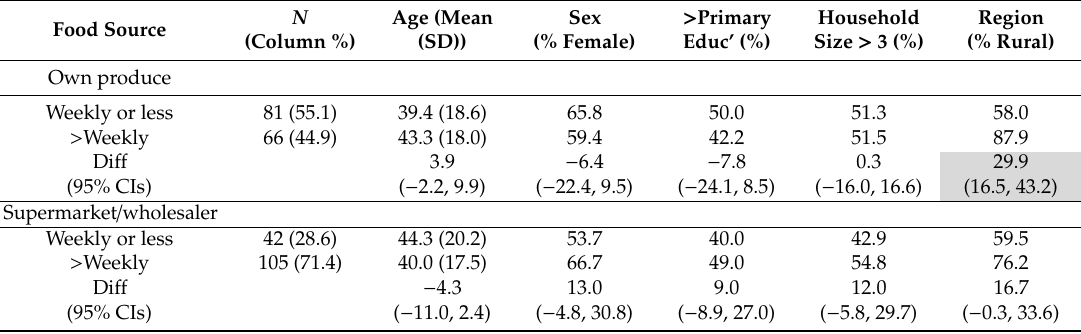
Table 5. Social and demographic characteristics of respondents in the CFaH project by frequency of use of selected food sources in SVG.